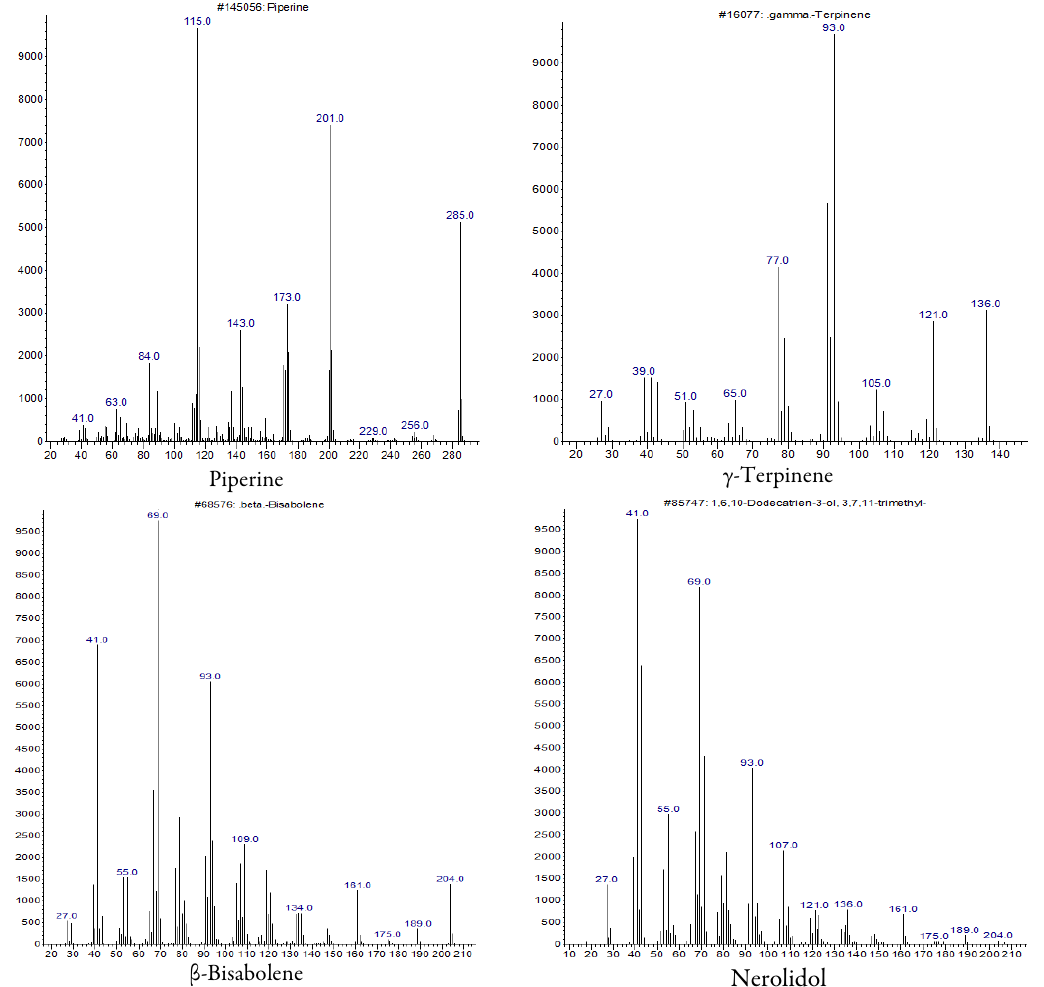
Figure 2. Spectra, chemical structures and molecular formulas of selected new bioactive compounds predominantly produced by UV treated L.